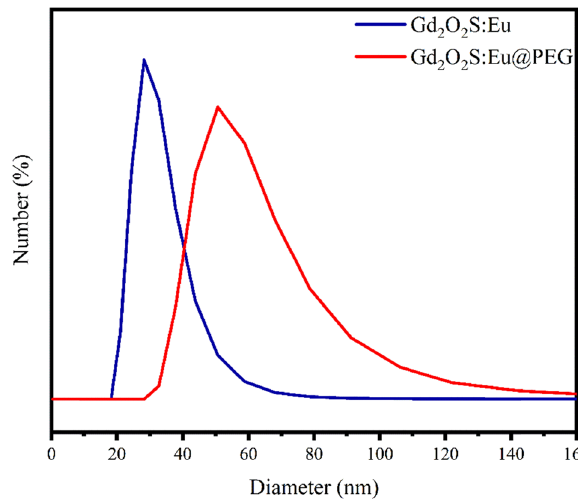
Figure 2: Particle size of Gd 2 O 2 S:Eu before and after modi fi cation measured by DLS.